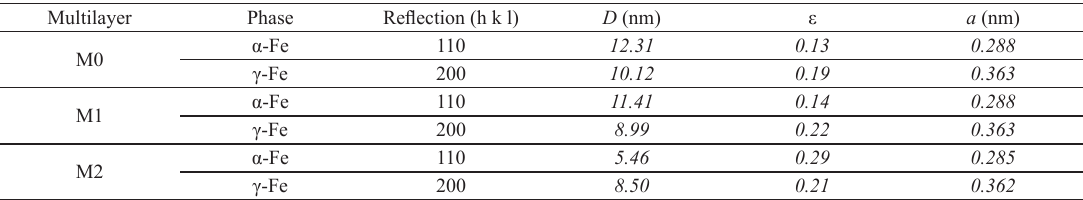
Table 1. Parameters obtained by means of XRD for coating deposited. D is grain size, ε is deformation percentage, and a is lattice parameter.